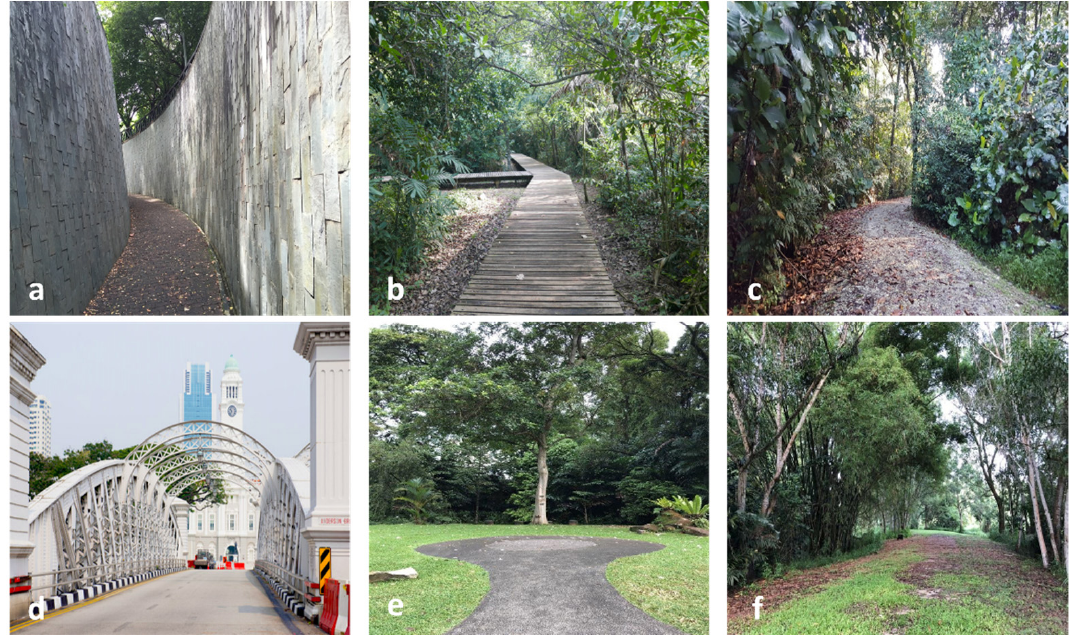
Figure 1. Sample images for the 6 conditions ( a = high mystery built, b = high mystery mixed, c = high mystery natural, d = low mystery built, e = low mystery mixed, and f = low mystery natural).